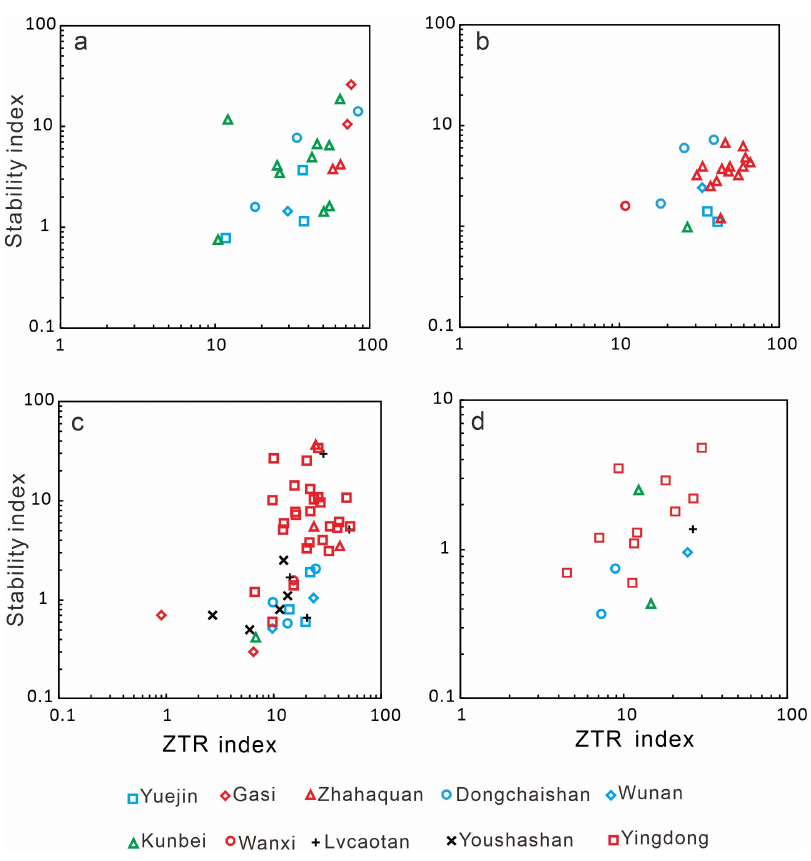
Figure 6. Binary plot of heavy mineral stability indexes (ZTR and stability indexes), ( a – d ) are for Xia Ganchaigou Formation, Shang Ganchaigou Formation, Xia Youshashan Formation, and Shang Youshashan Formation, respectively. The data are shown in Tables S2–S5.